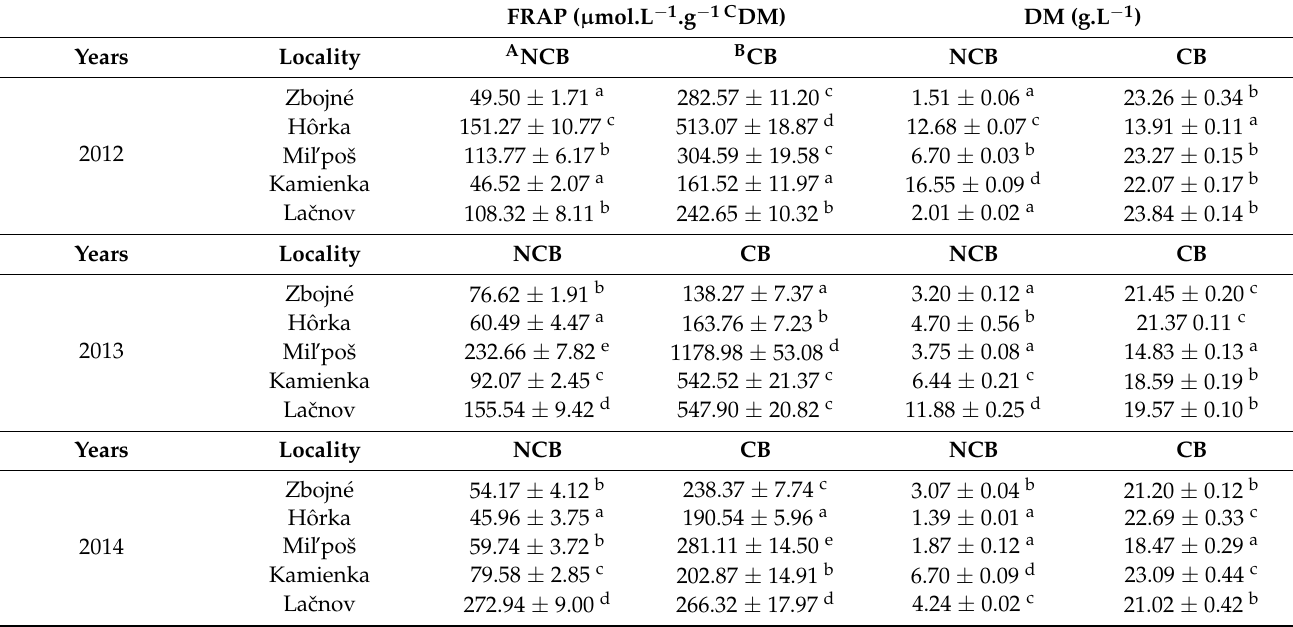
Table 2. Ferric reducing ability of plasma (FRAP) assay and the dry matter content in 70% ethanol extracts juniper berries.